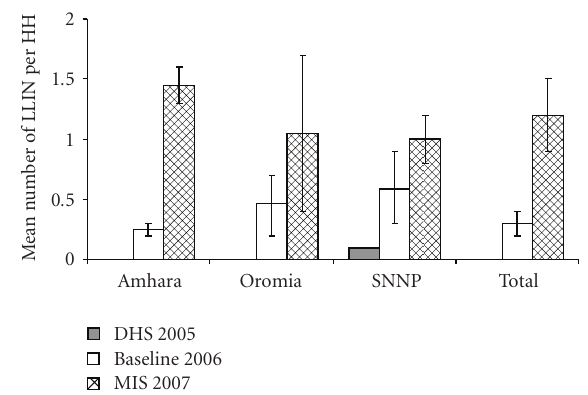
Figure 4: Mean number of long lasting insecticidal nets per household by survey and regional